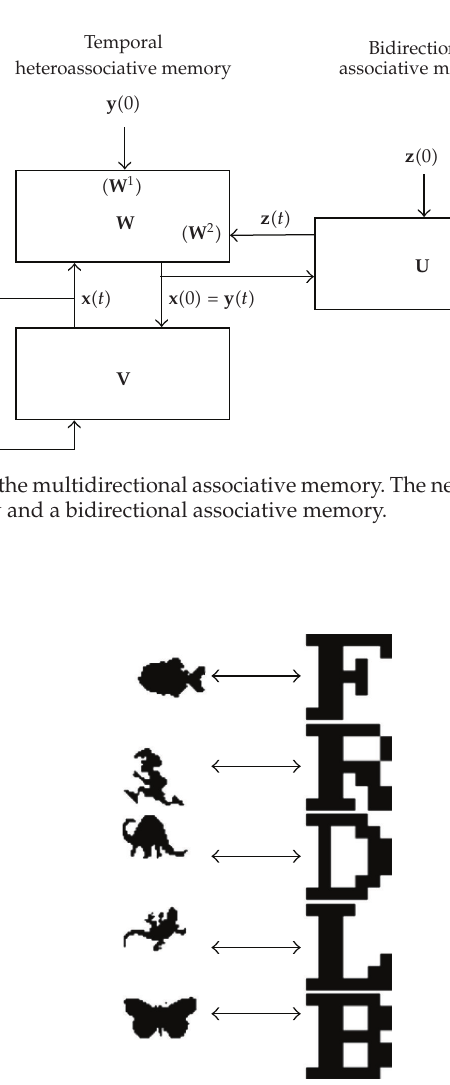
Figure 19: Patterns pairs used to trained the